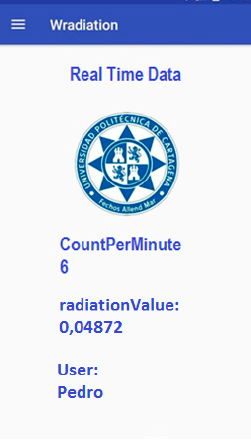
Figure 18. Dose values screen shot.